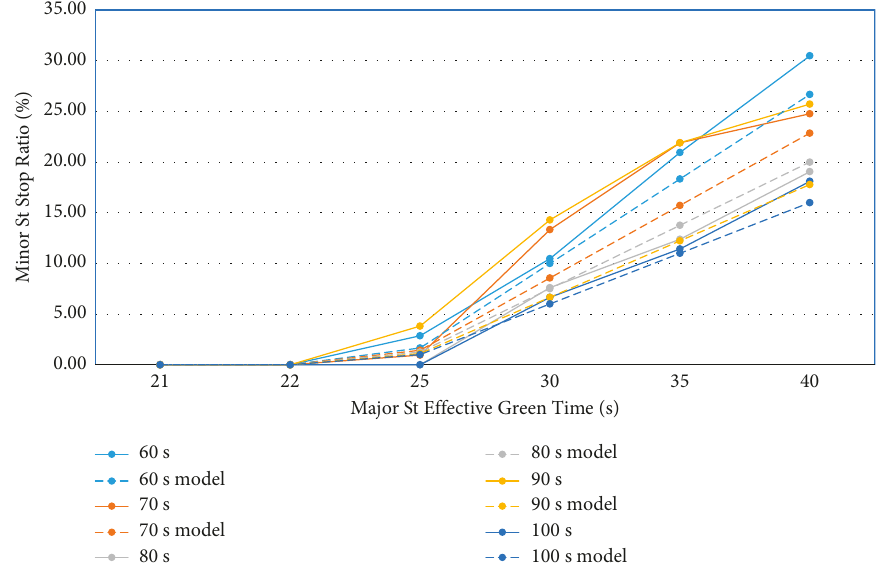
Figure 7: Minor St tolerance stop ratio of coordination plans under the volume of 100vph.